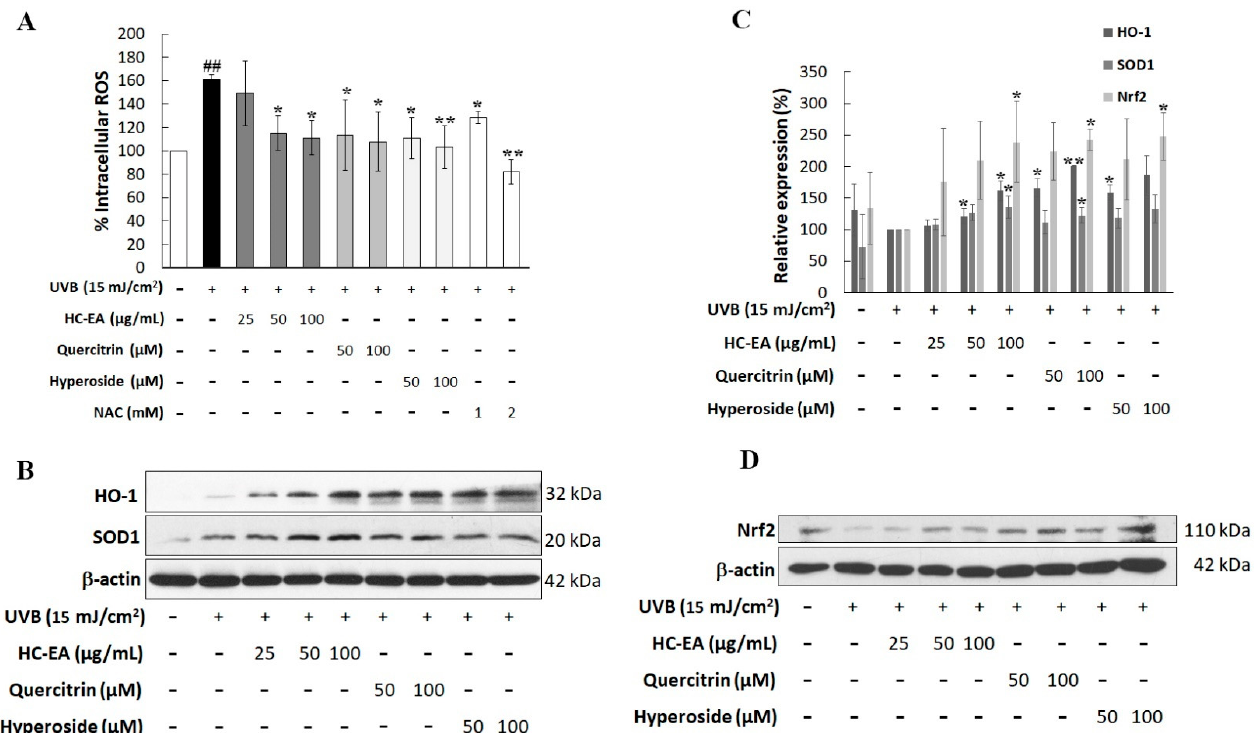
Figure 5. Antioxidant potential of HC-EA and its active compounds on UVB-induced HaCaT cells. ( A ) The production of intracellular ROS in HaCaT cells was measured at 2 h after UVB irradiation (15 mJ/cm 2 ) by using DCF-DA dye, then the fluorescent intensity was determined by spectrofluorometer. The effect of HC-EA and its bioactive compounds on the expression of antioxidant proteins SOD and HO-1 ( B ) and transcription factor Nrf2 ( D ) were evaluated by Western blotting. Densitometric and statistical analysis of protein quantification data normalized to β -actin are presented as histogram ( C ). All experiments were performed at least three times. * p < 0.05, ** p < 0.01, as compared to the UVB-irradiated alone group. ## p < 0.01 as compared to the control group. Data are representative of three independent experiments as mean ±